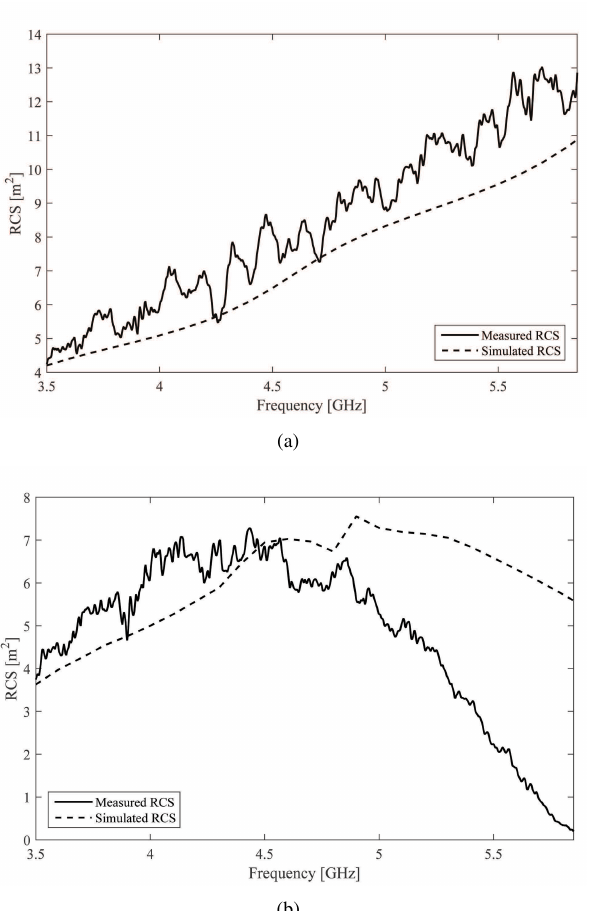
Figure 12: (a) Comparison between simulation and mea- surement for the metal plate; (b)Comparison between sim- ulation and measurement for the